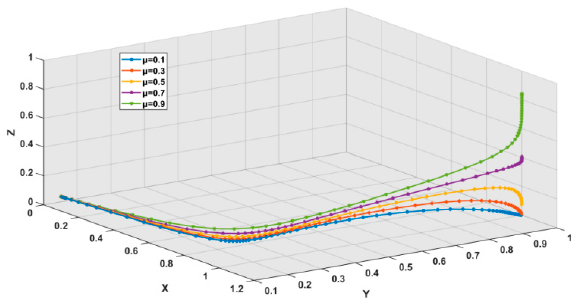
μ on the system’s evolution trajectory.